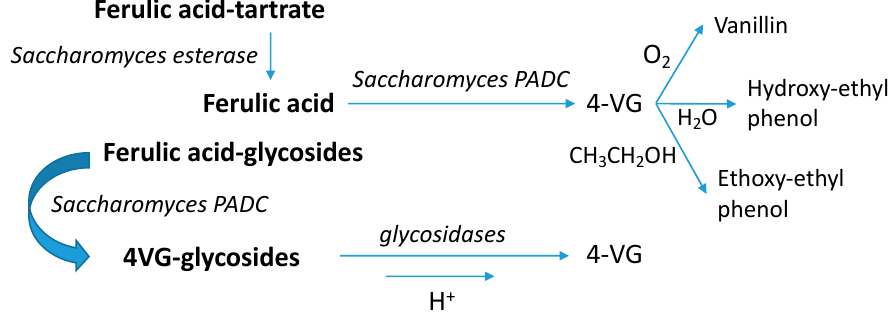
Figure 11. Scheme showing the main di ff erent processes leading to the production of 4-vinylguaiacol (4VG) during fermentation and